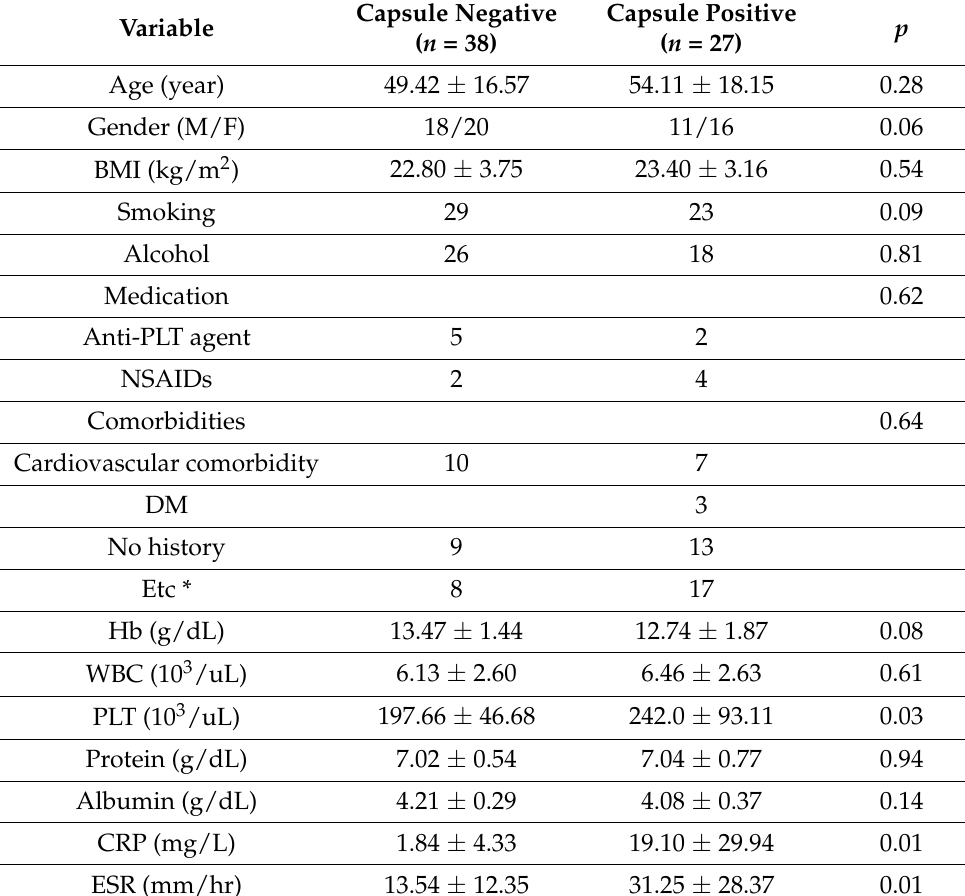
Table 1. Patients’ Baseline